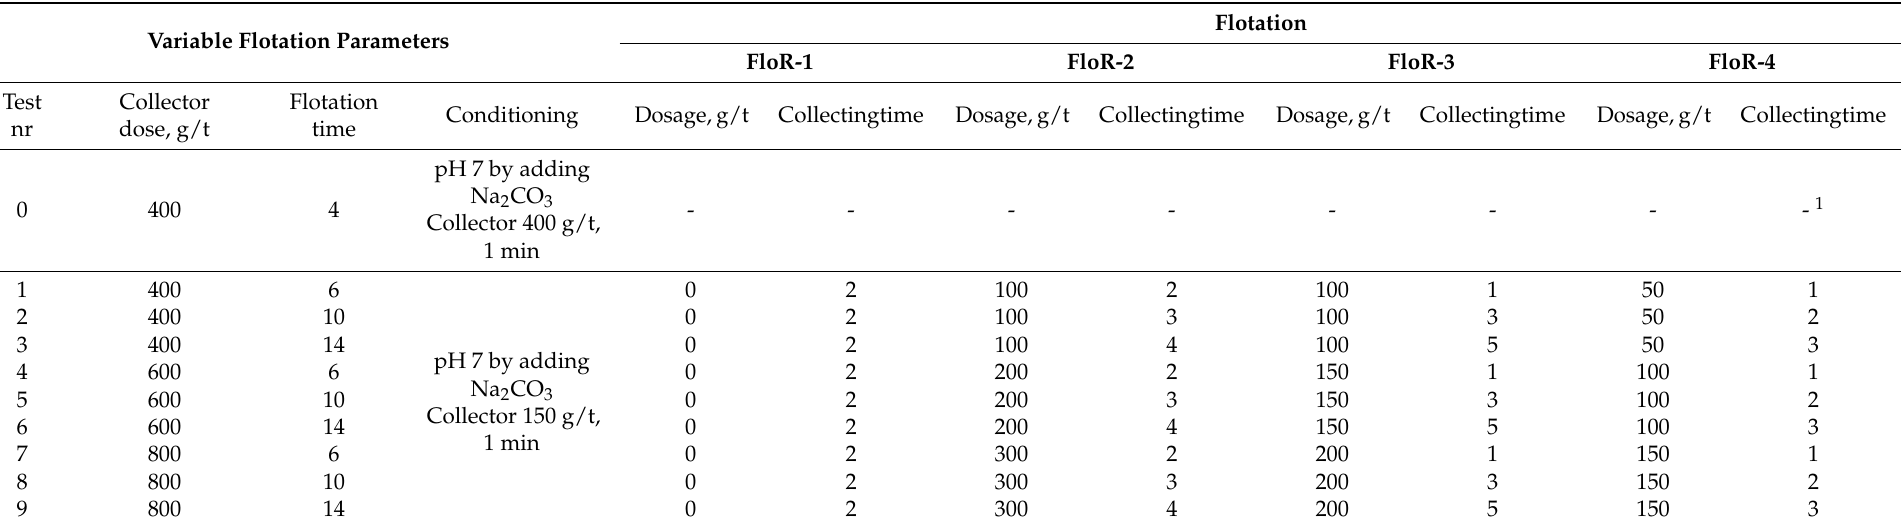
Table 1. Estonian phosphate rock beneficiation in 10 distinct tests regarding collector dosage and flotation